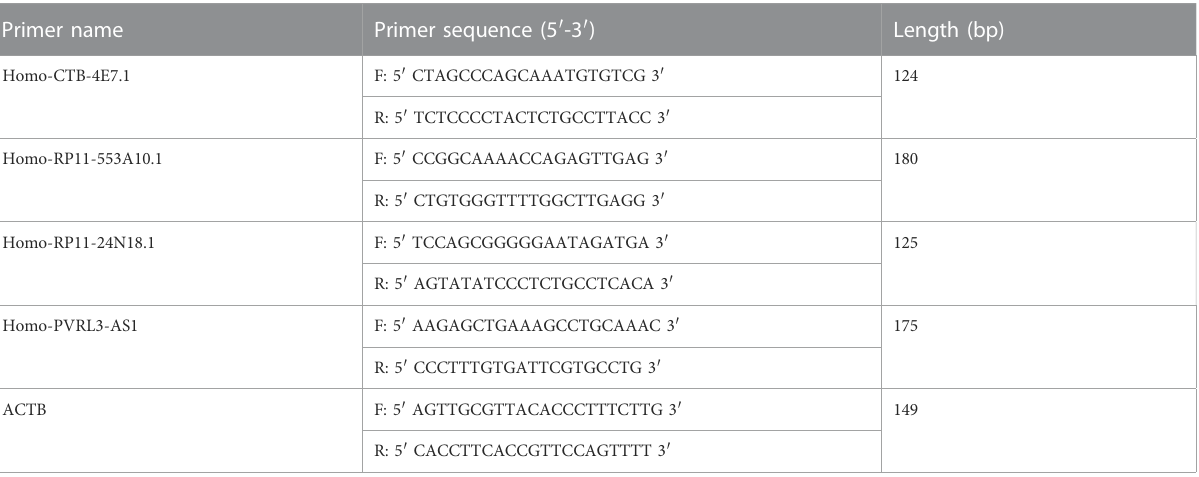
TABLE 1 Speci fi c primer sequences for